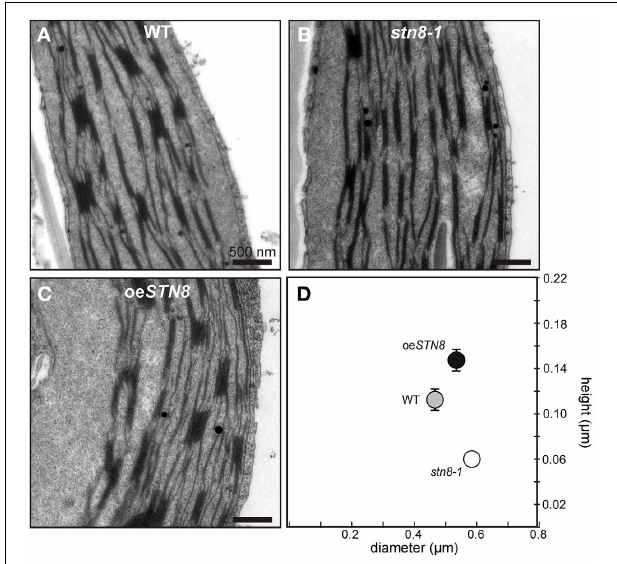
FIGURE 8 | Altered STN8 levels affect thylakoid ultrastructure. (A–C) True leaves of 4-week-old WT (Col-0), stn8-1 and oe STN8 plants grown at 100 μ mol photons m − 2 s − 1 at a 12/12h night/day cycle were fixed 2h after the onset of light and analyzed by transmission electron microscopy (TEM). Representative cross-sections of chloroplasts are shown for WT (A) , stn8-1 (B) and oe STN8 (C) , respectively. Bars represent 500nm. (D) Scatter plot of the average grana diameter and height values ( n = 30) in the genotypes shown in (A–C) . Bars represent the respective standard errors of the mean